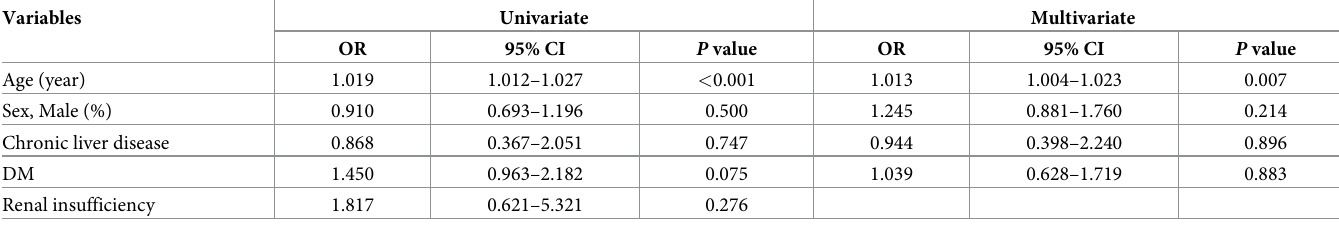
OR, odds ratio; CI, confidence interval; DM, diabetes